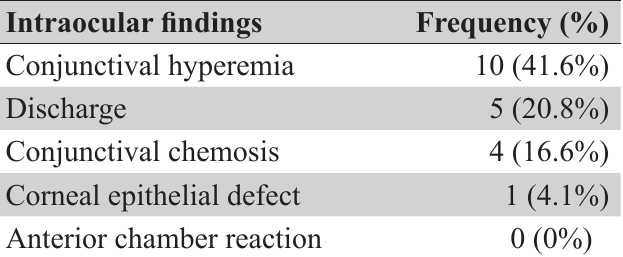
Table 2.Intraocular Findings and Their Frequency (n=24).